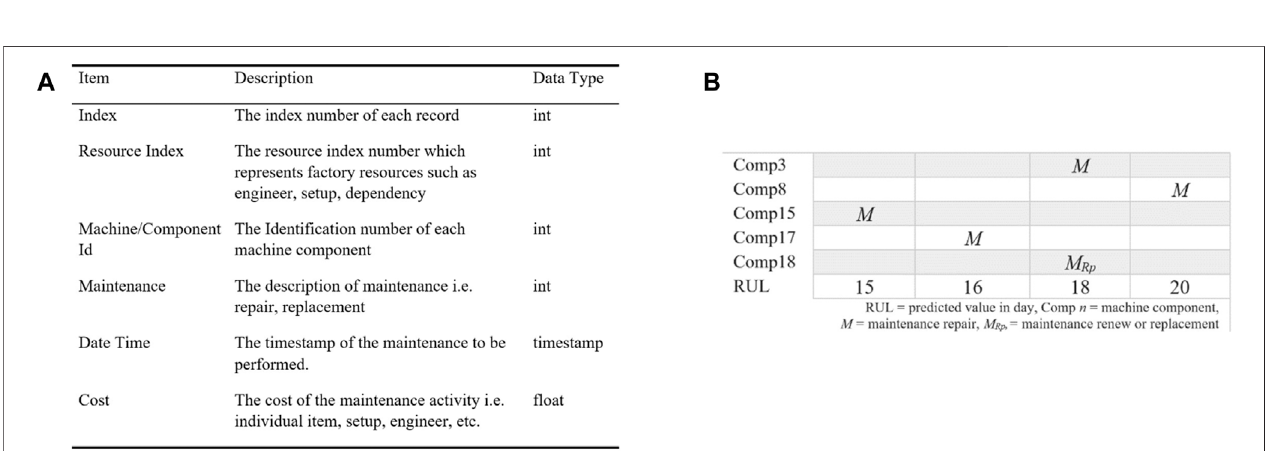
Frontiers in Big Data |